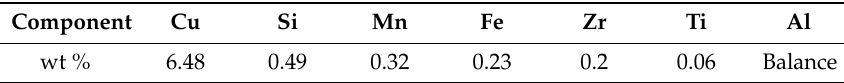
Table 1. Chemical composition of 2219 aluminum alloy (wt